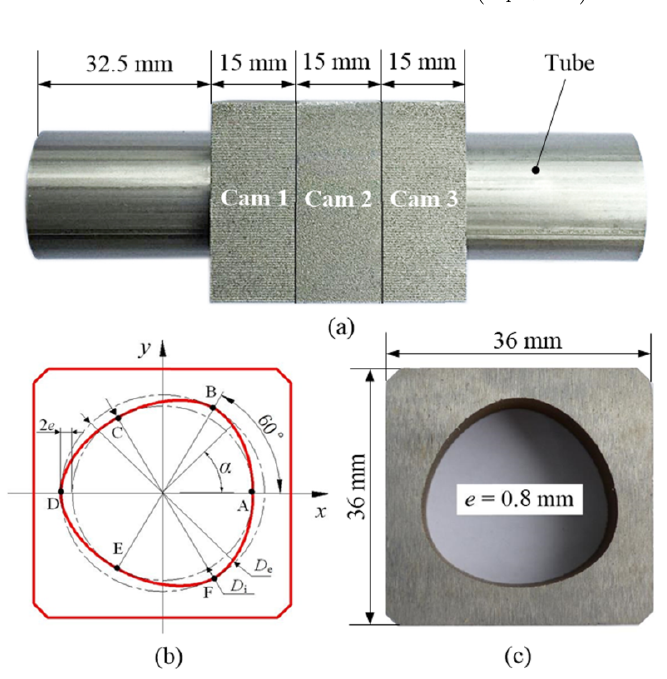
Figure 1. ( a ) Schematic of the assembled camshaft, ( b ) schematic of the isometric-trilateral profile of the cam and ( c ) actual image of the cam [28]. Table 1. Chemical composition of SUS304 tube and 45 steel cam (wt.%).